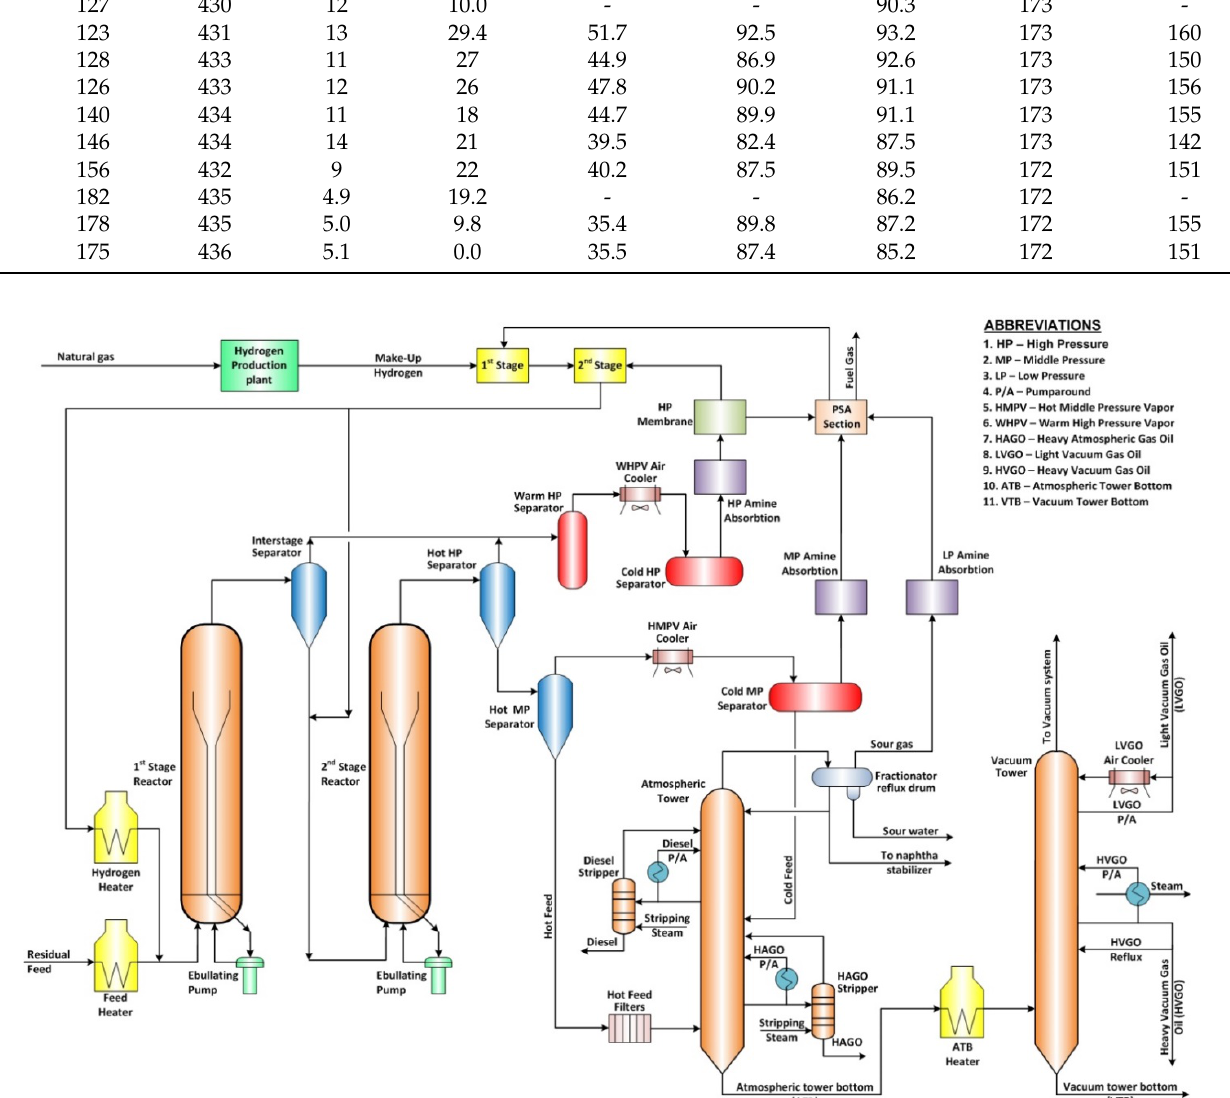
Figure 7. Process flow diagram of the LUKOIL Neftohim Burgas ebullated bed residue H-Oil ® hydrocracker. Table 5. Operating conditions in LNB H-Oil ® hydrocracker for the studied 36 cases.